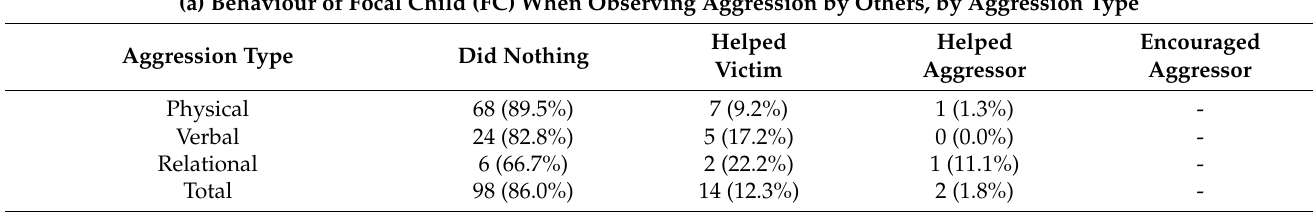
(b) Behaviour of Onlookers When Focal Child (FC) Observed Being Aggressive/Victimised by Behaviour Type Aggression/Victimisation